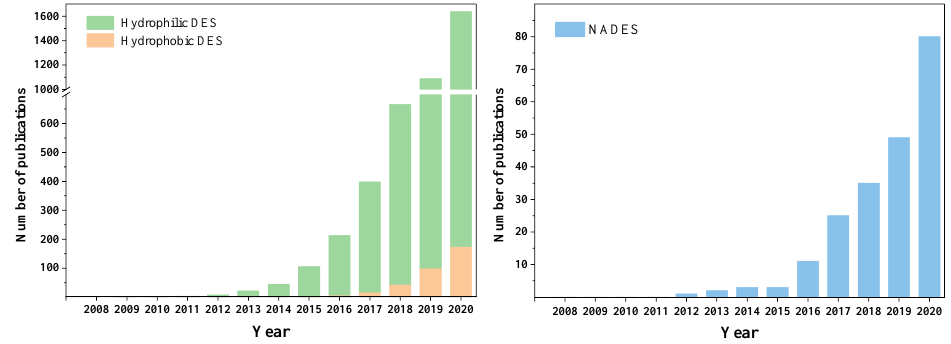
Figure 1. Number of papers published during 2008–2020 in Web of Science (Keywords: “deep eutectic solvents”, “hydrophobic deep eutectic solvents”, and “nature deep eutectic solvents” with “extraction” ).